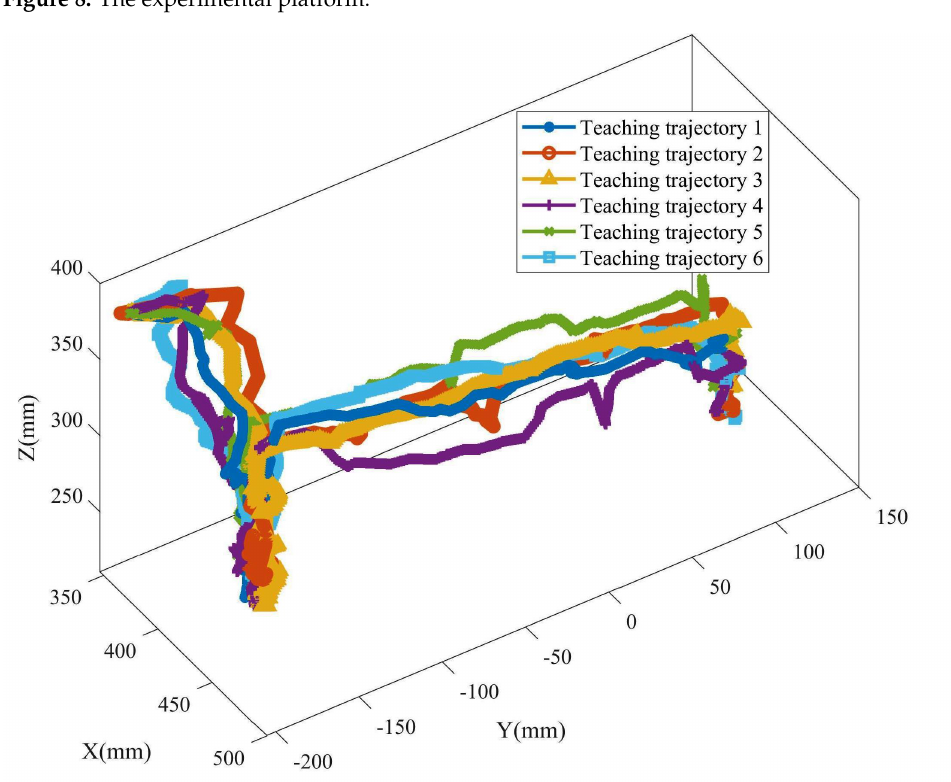
Figure 9. Teaching trajectory of the experimental